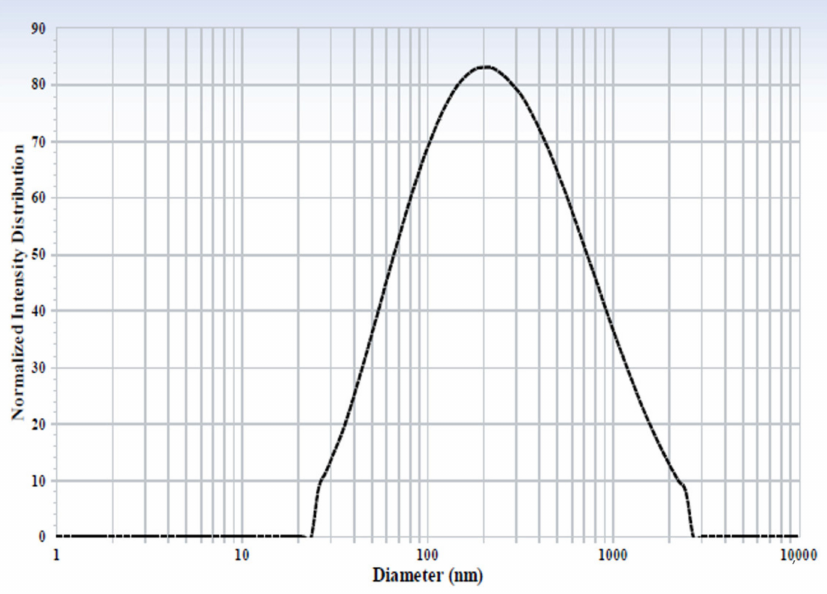
Figure 2. Particle size and size distribution of LPV/RTV